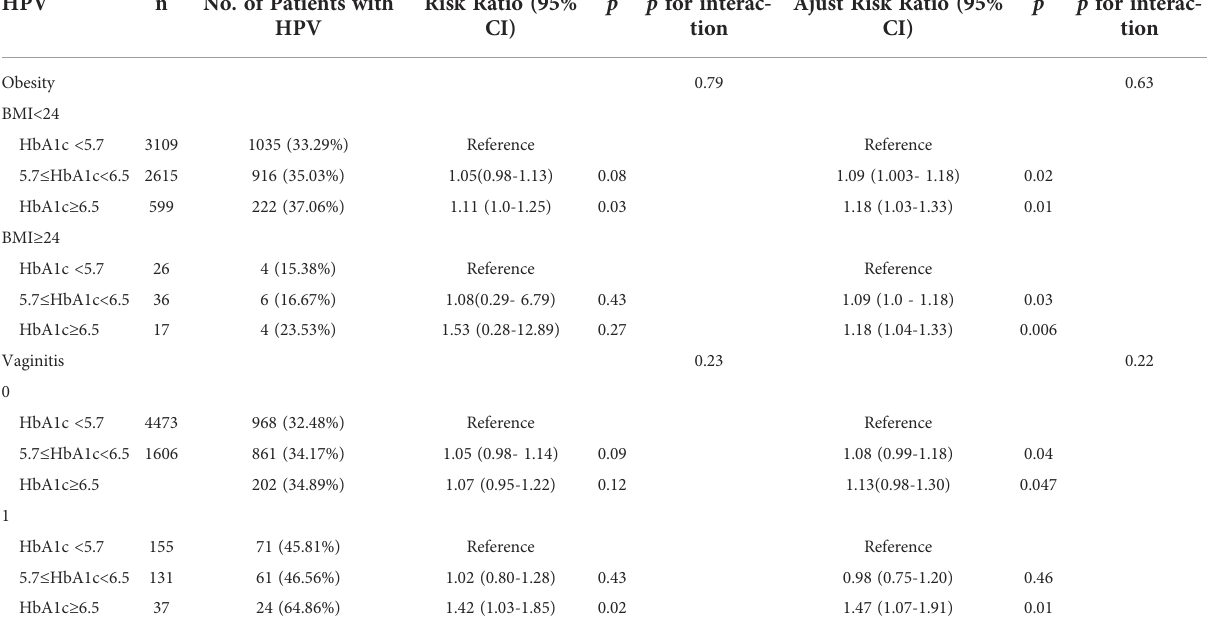
TABLE 4 Subgroup analysis of Risk Ratios for HPV.